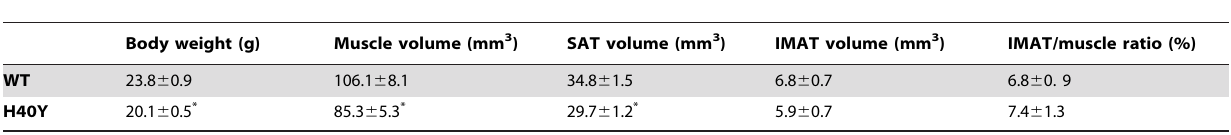
Table 1. Anatomical measurements in H40Y and WT groups.